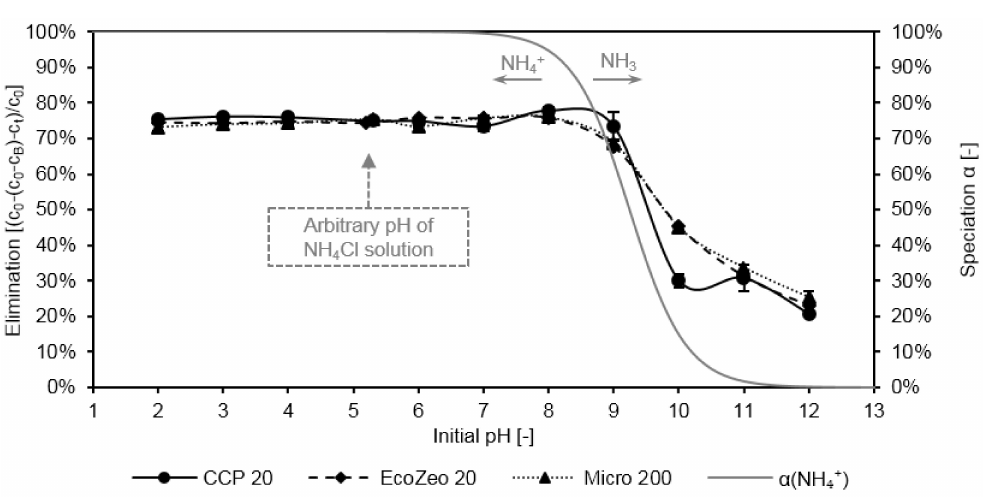
Figure 2. Elimination of ammonium by CCP 20, Micro 200, and EcoZeo 20 after 20 h contact time from NH 4 Cl solution (c 0 = 1000 mg NH 4 -N/L, sorbent ration 0.1 g CLI /mg NH4-N ) as well as speciation α of ammonium as a function of